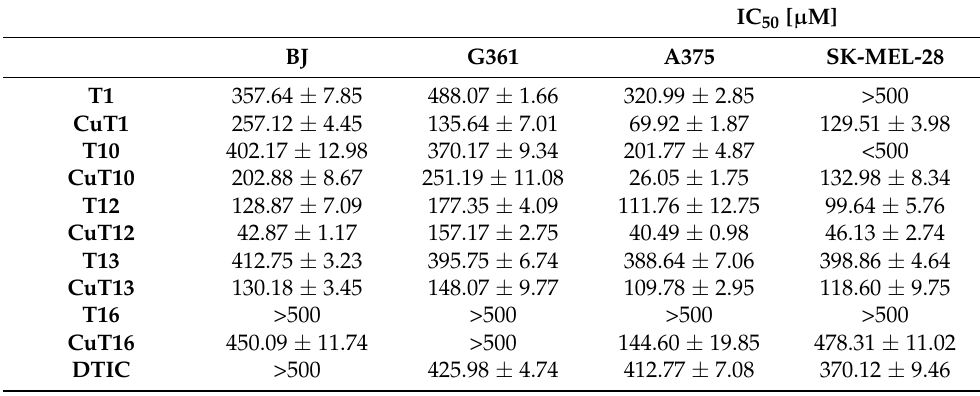
Table 3. IC 50 values obtained for tested compounds and dacarbazine (DTIC) based on 3-(4,5- dimethylthiazol-2-yl)-2,5-diphenyltetrazolium bromide test (MTT test) results after 24 h treatment of melanoma and normal fibroblast cell